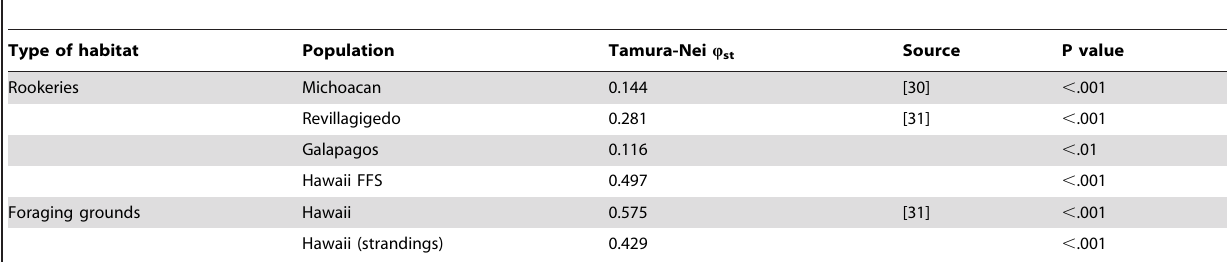
Table 3. Genetic distances ( Q ST, Tamura-Nei model) between the Gorgona FG green turtle aggregation and other Pacific nesting and feeding aggregations.